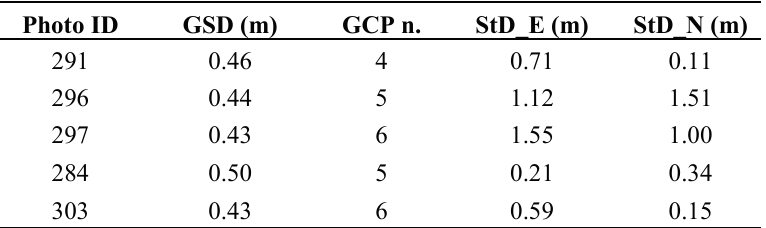
Table 3. Test 2—2006 lava flow in Valle del Bove (Mt Etna): statistics of post adjustment residuals of GCPs adopted for extracting each DO: ground resolution (GSD), number of GCPs, standard deviations (StD) on the East and North components.